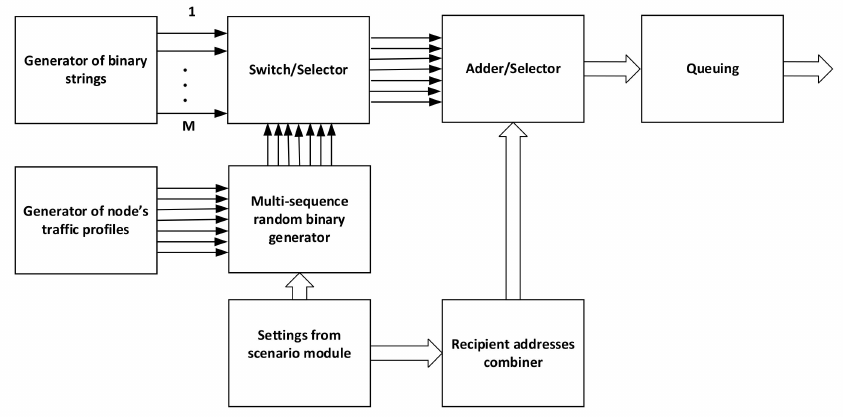
Figure 6. Generator block